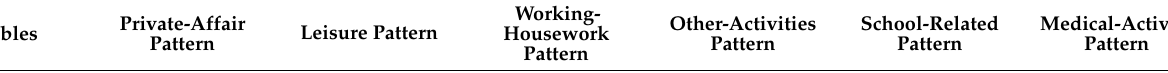
Table 3. Results of the multilevel multinomial logit